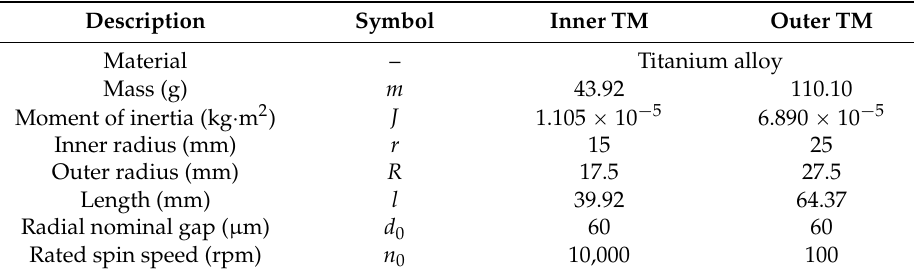
Figure 3. Exploded view of the differential accelerometer core. The inner and outer test masses are aligned concentrically and coaxially. The sensitive axis of the NEP test is along the x direction. Table 2. Physical properties of the two test masses.